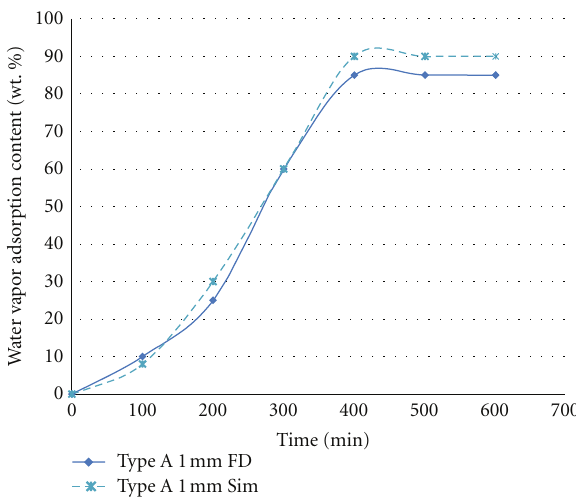
Figure 13: Influence of the silica gel size and number on the breakthrough